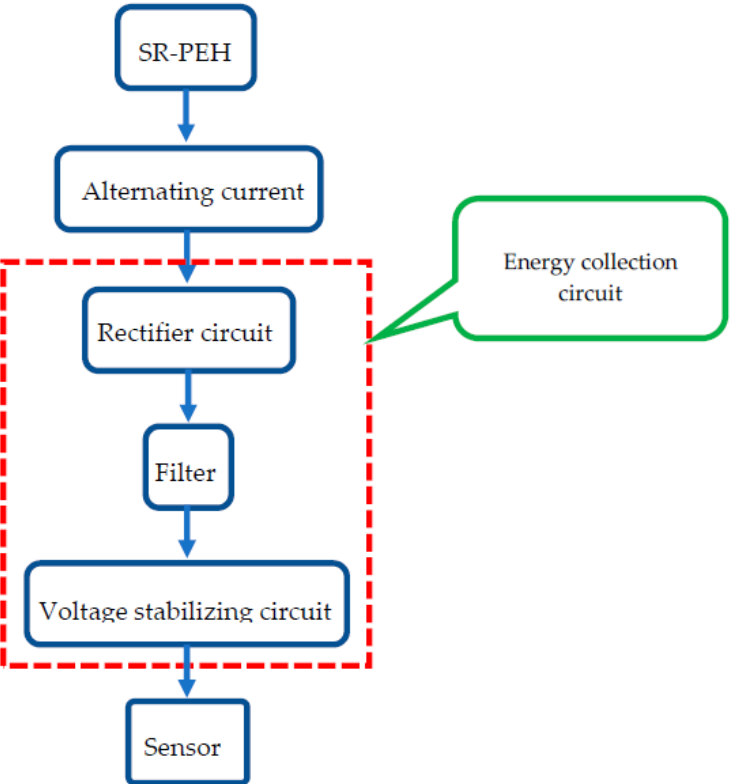
Figure 3. The microelectromechanical system (MEMS) integration process.